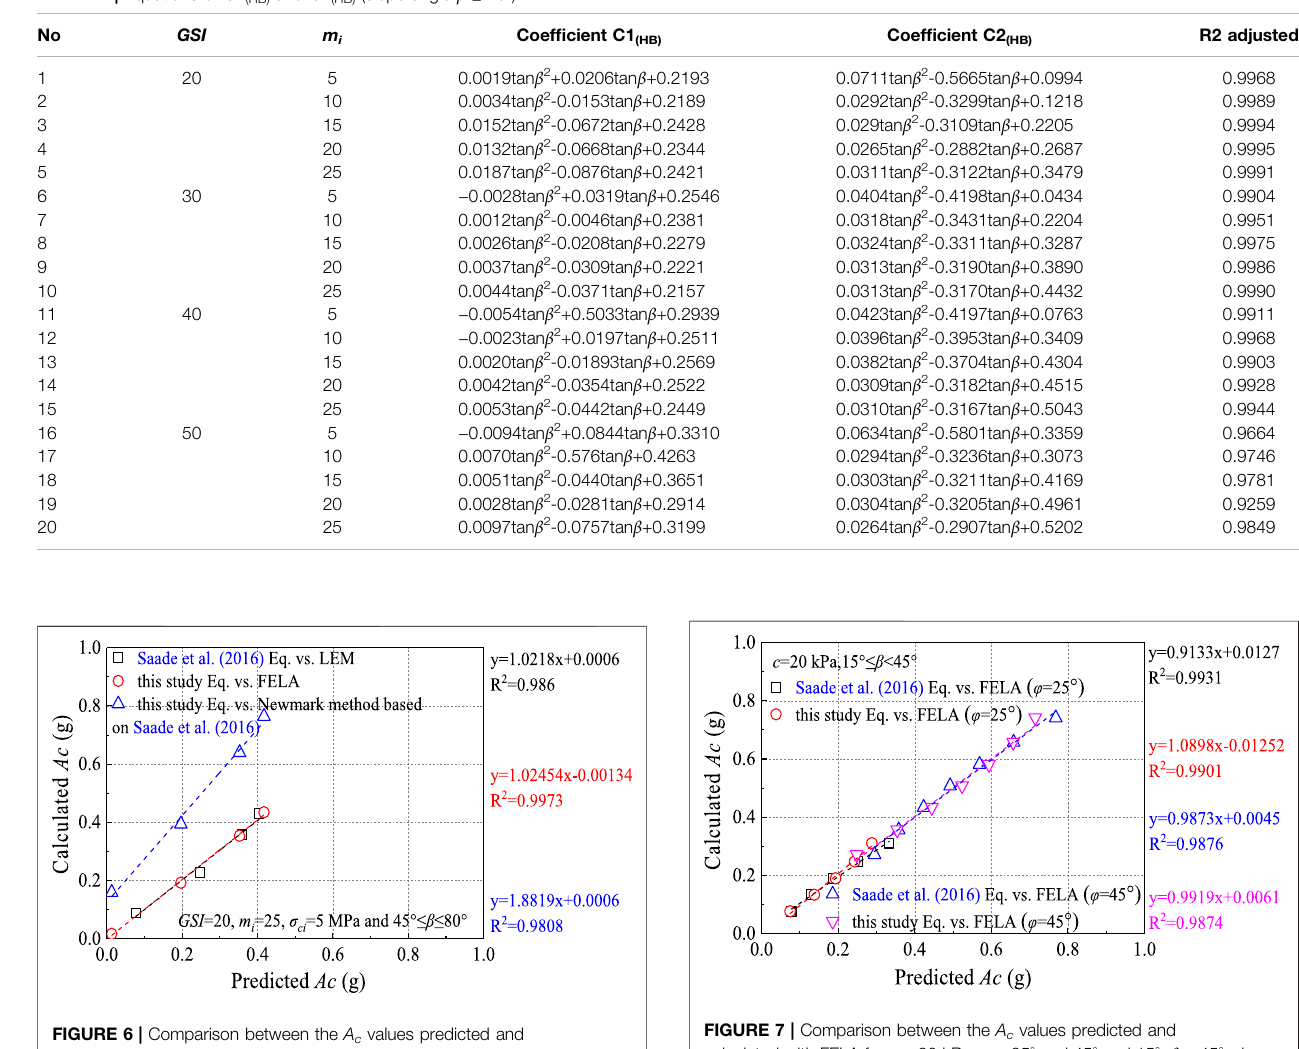
TABLE 4 | Equations of C1 (HB) and C2 (HB) (slope angle β ≥ 45 ° ).